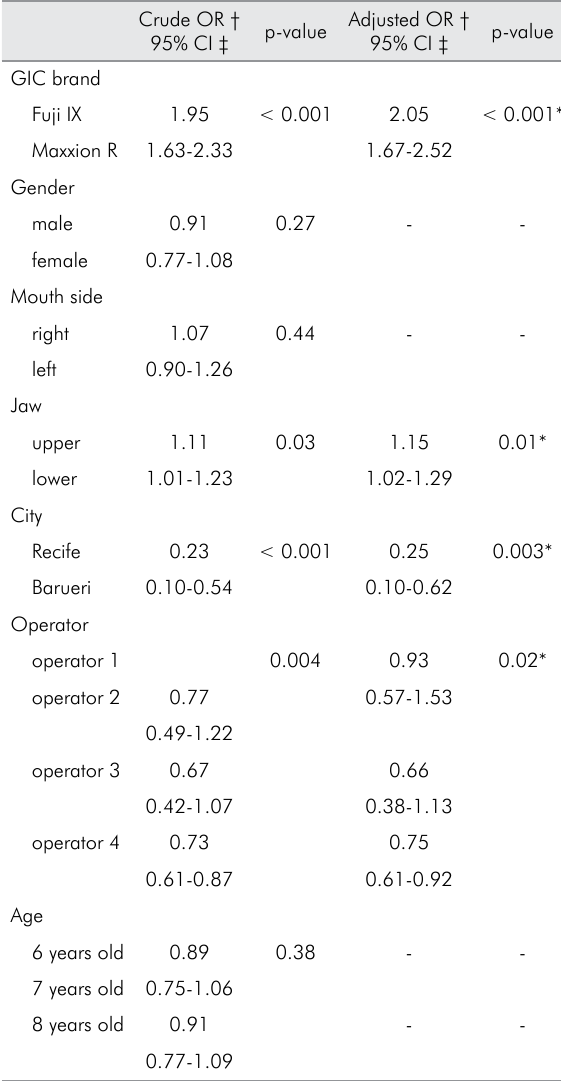
Table 2. Univariate and multiple logistic regression analysis of sealant retention and associated factors after 12-month